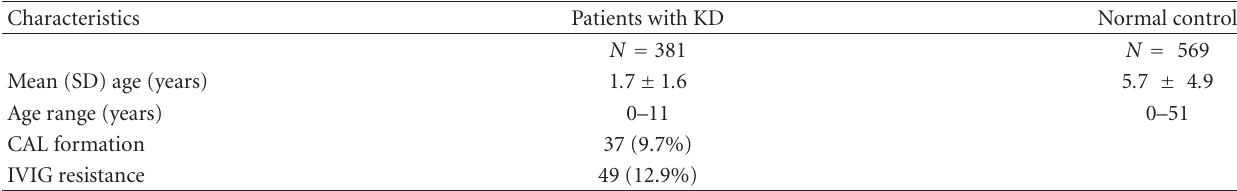
Table 1: Basal characteristics of patients with Kawasaki disease and normal controls.